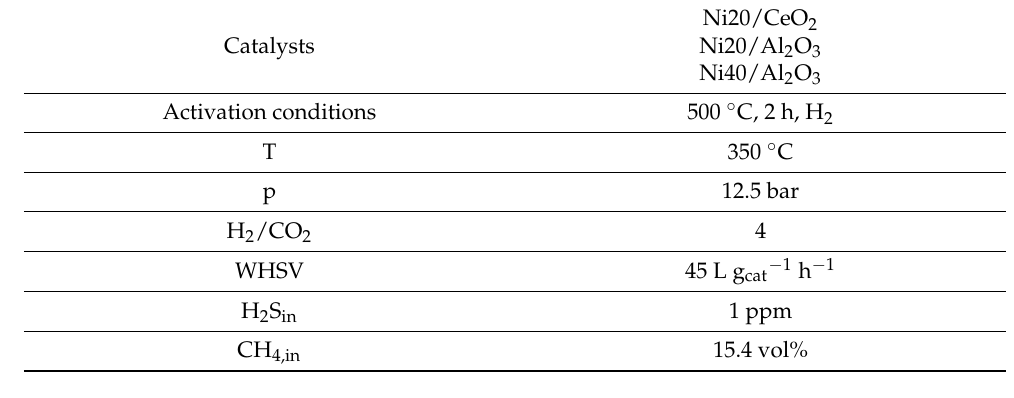
Table 13. Catalysts and reaction conditions for experiments on H 2 S influence on methanation with unpromoted Ni catalysts in a microchannel micro reactor [99].